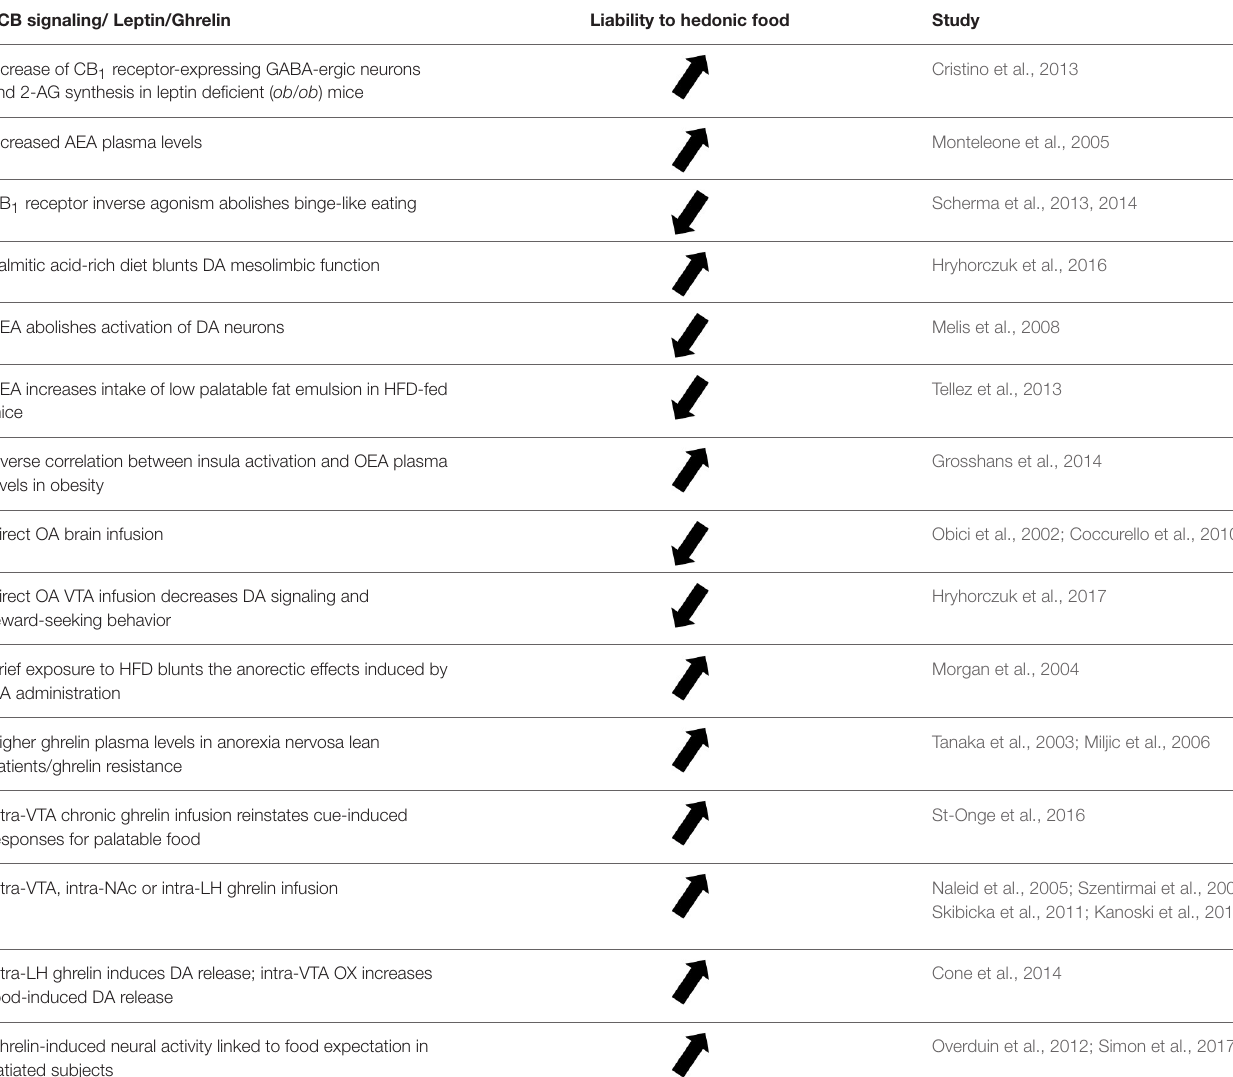
TABLE 2 | Selected studies showing the crosstalk between eCB signaling, leptin and